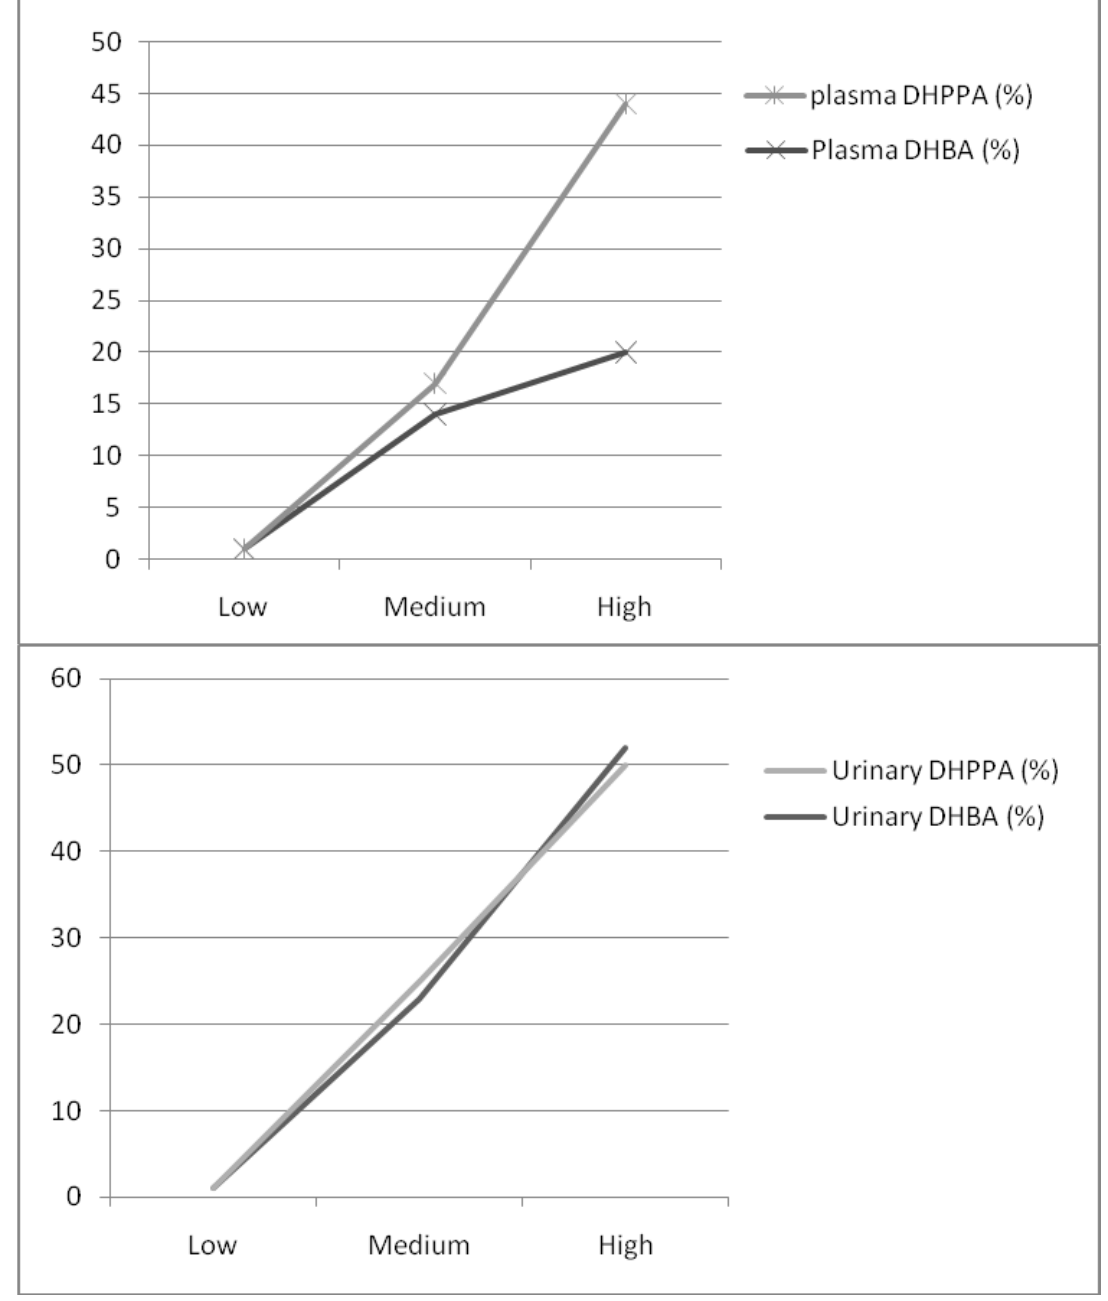
Figure 1. Responsiveness (%) of urinary and plasma alkylresorcinol metabolites between medium or high rye intake group and low rye intake group